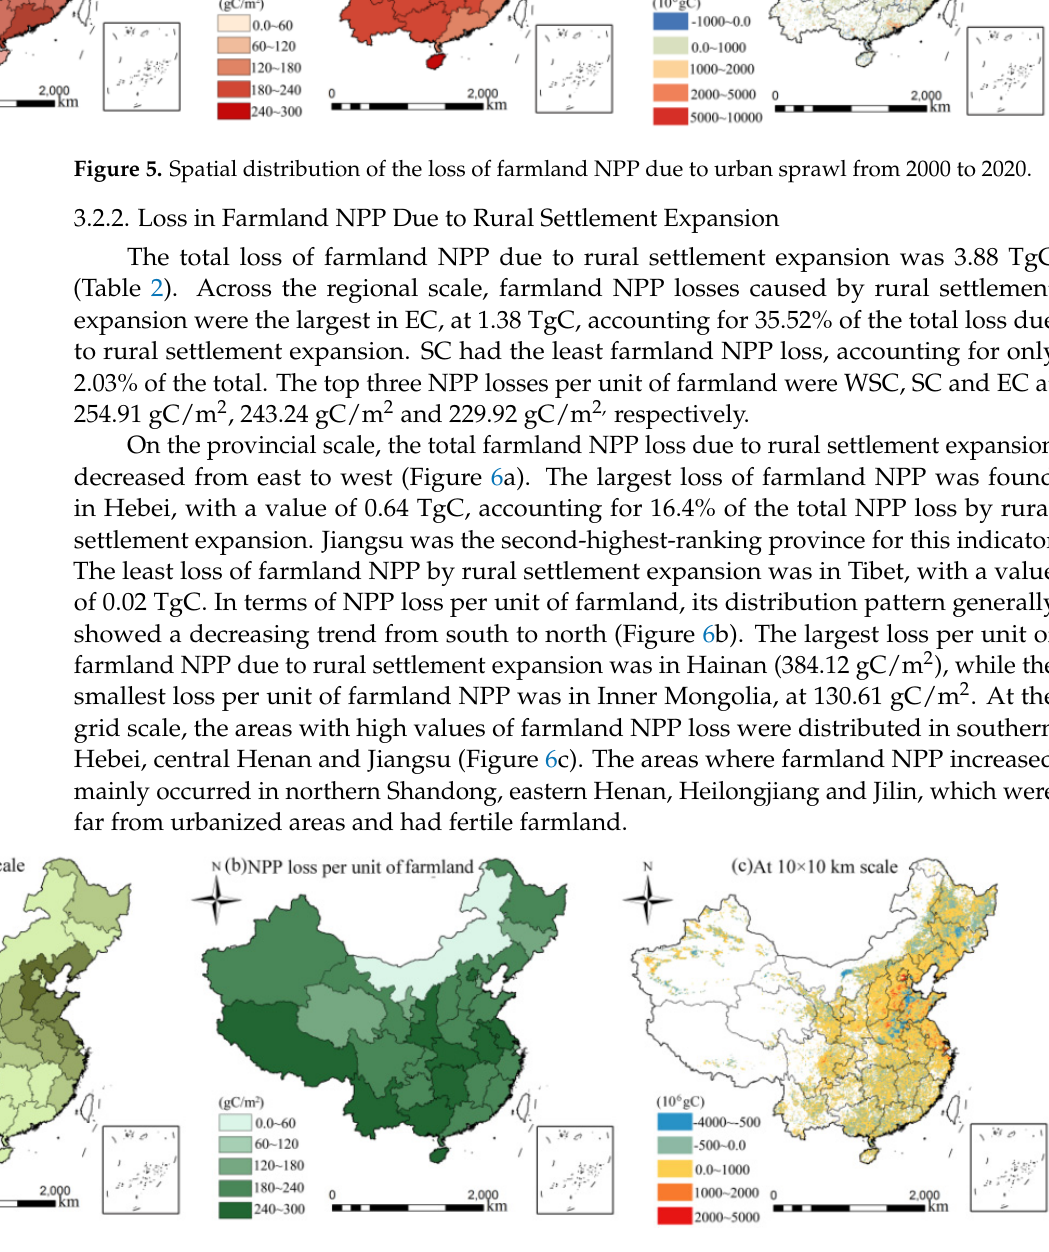
Figure 6. Spatial distribution of the loss of farmland NPP due to rural settlement expansion from 2000 to 2020. 2000 to